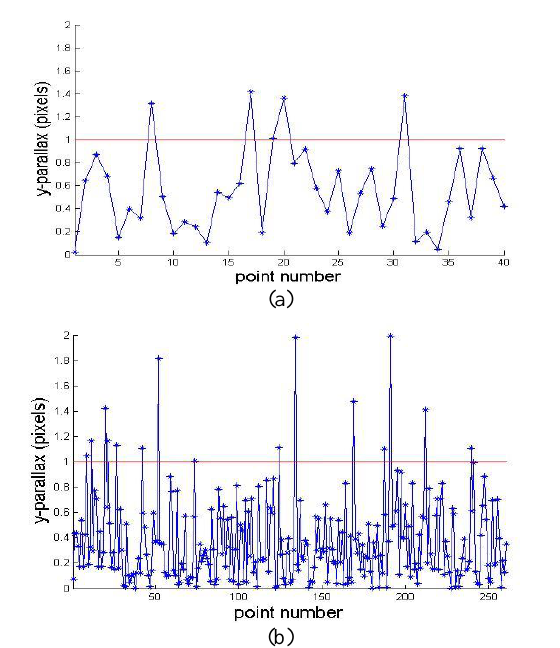
Figure 10. The y-parallaxes of corresponding points: